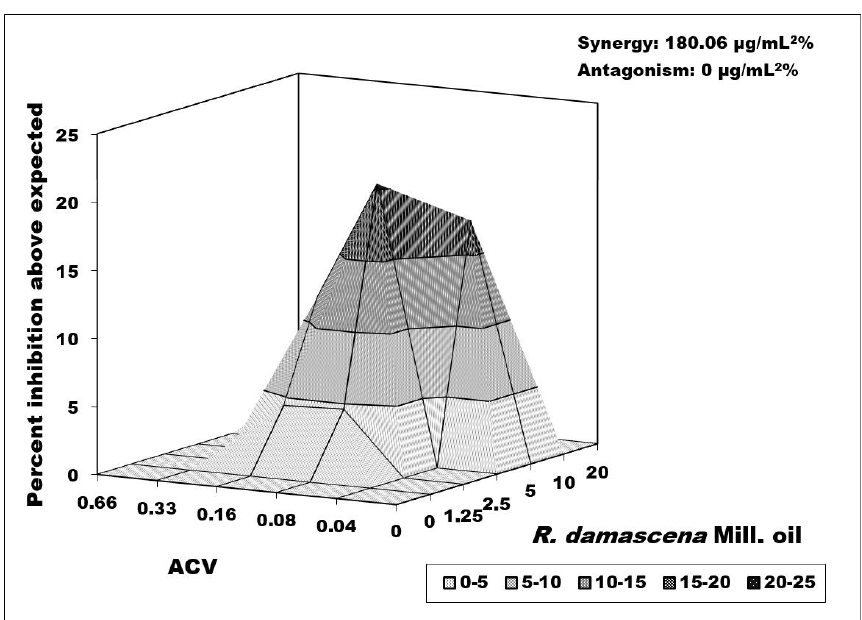
Figure 3. Combined effect of Rosa damascena Mill. essential oil and acyclovir on HSV-1 replication (Victoria strain). Data processing is described in detail in Section 2.10.